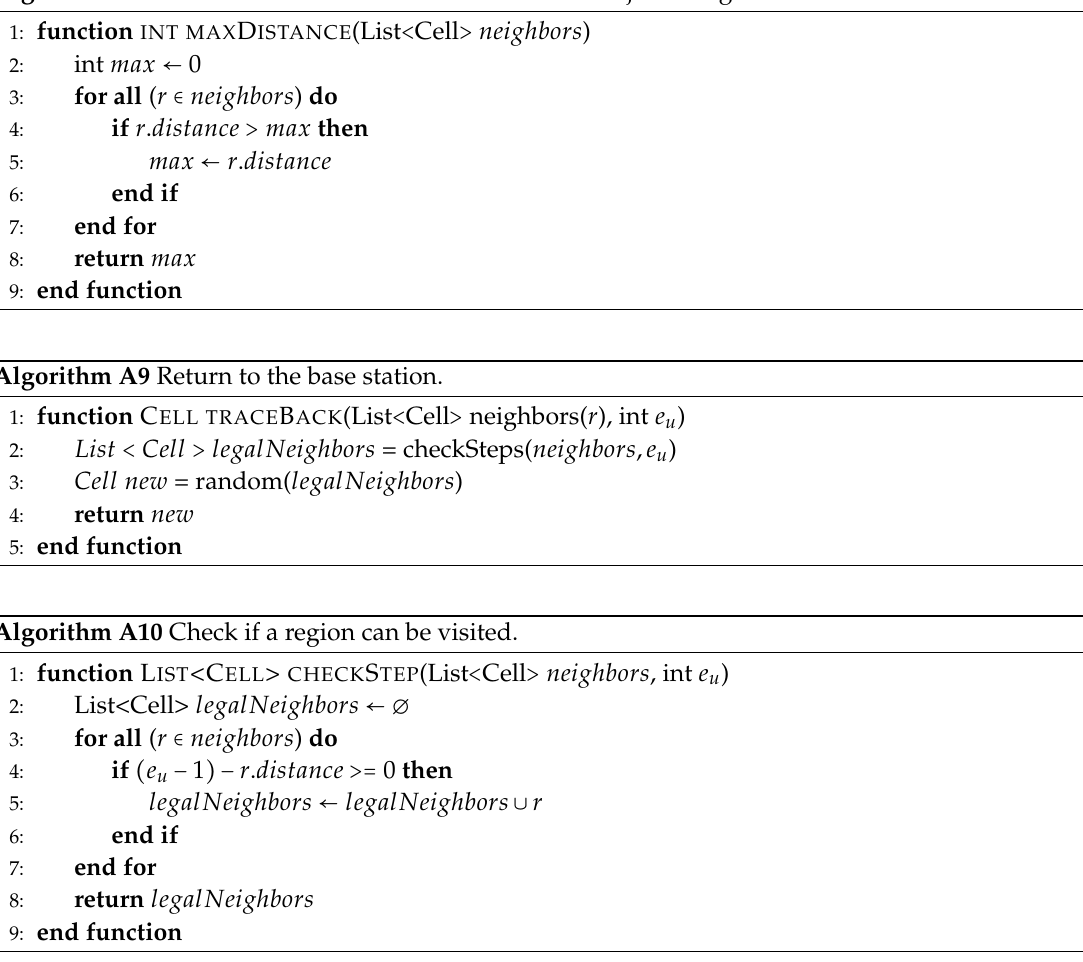
Algorithm A8 Get the maximum distance between the adjacent